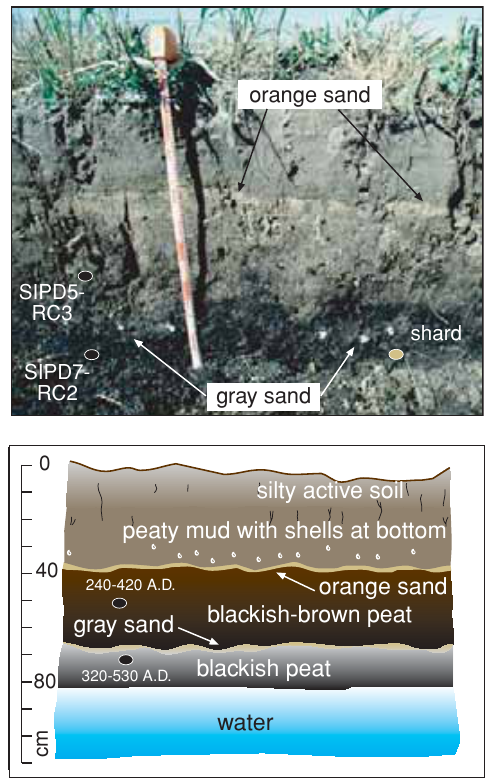
Fig. 11. Siponto site: picture of the two tsunami sands from ditch 5 (above) and simplified sketch of the upper 1 m of stratigraphy studied in the ditches (below). The location of two charcoal samples and of the shard is also plotted with a black